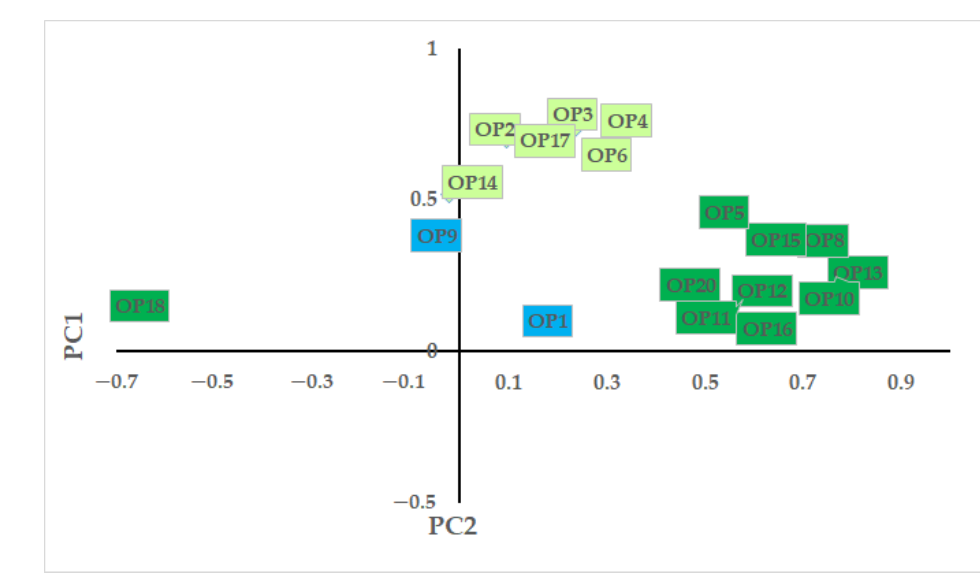
Figure 2. Results of the principal component analysis on responses to statements on coexistence with hooded crows. Note: t otal explained variance: 55.2%; Bartlett’s test of sphericity: χ 2 = 14219.47, p < 0.001; KMO = 0.932; Cronbach’s α = 0.815. OP1: I would like to be involved in projects that aim